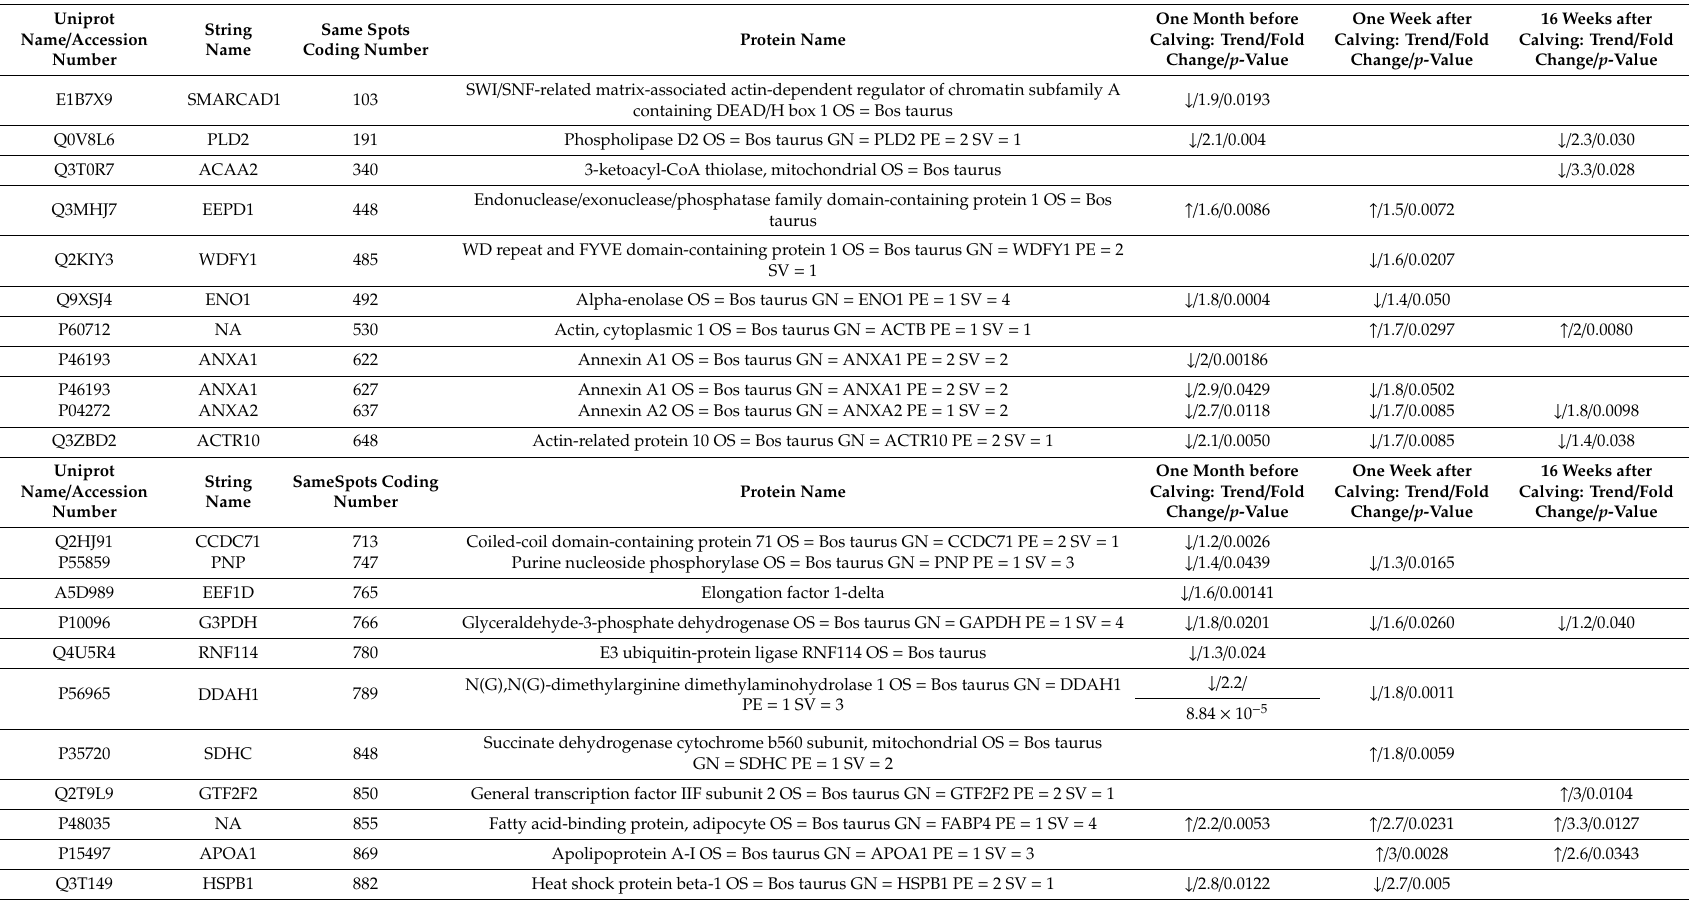
Table of di ff erentially expressed proteins. ↑ : proteins overrepresented in high negative energy balance. ↓ : proteins underrepresented in high negative energy balance. OS: Organism; GN: gene name; PE: Protein existence; SV: Sequence